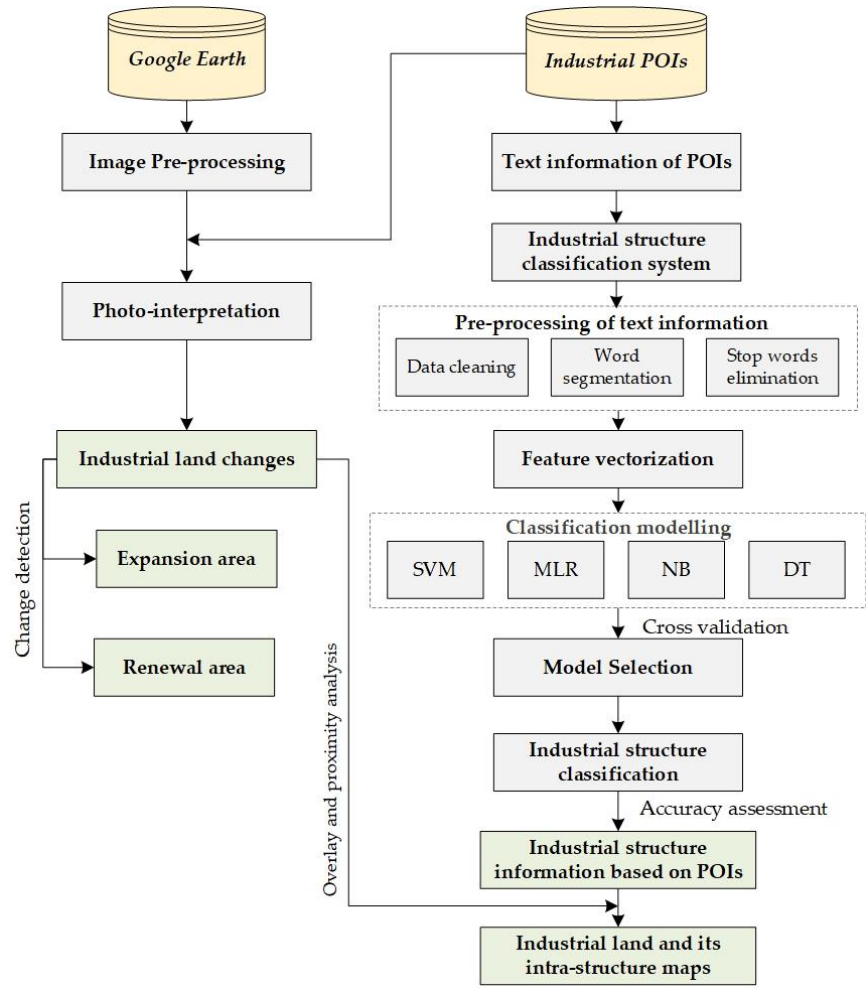
Figure 2. Flowchart of the methodology.